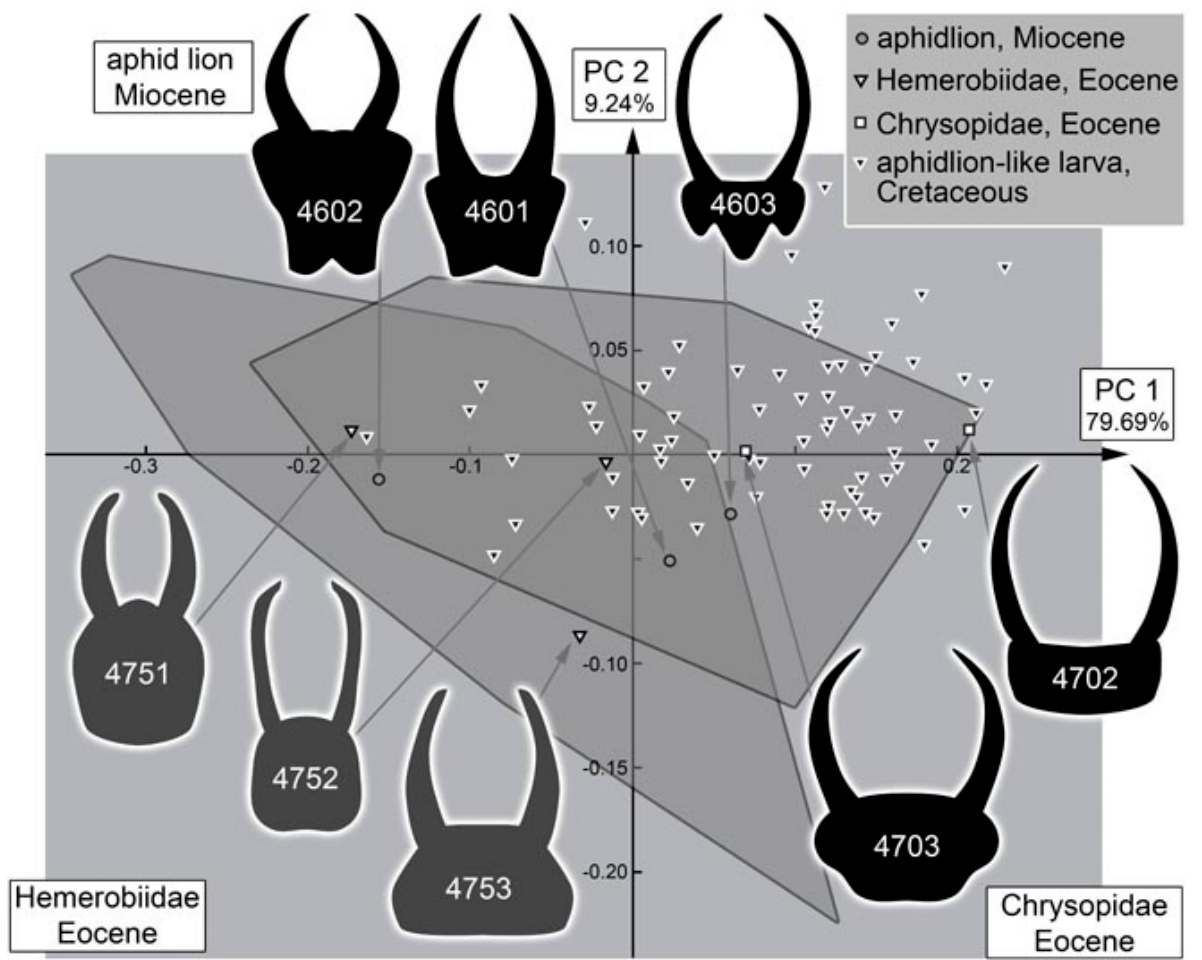
Figure 53. Scatter plot of PC2 vs. PC1 of head shapes of extant and fossil aphidlions and aphidlion- like larvae, continued. Polygons mark areas occupied by modern representatives of Chrysopidae and Hemerobiidae (as in Figure 52), with data points of extant specimens omitted. Head shapes of Hemerobiidae from the Eocene are exemplified by grey outlines and head shapes of Chrysopidae from the Eocene and of (presumable) Chrysopidae from the Miocene are exemplified by black outlines. Note that all larvae from the Eocene and Miocene plot within the area of the modern forms.